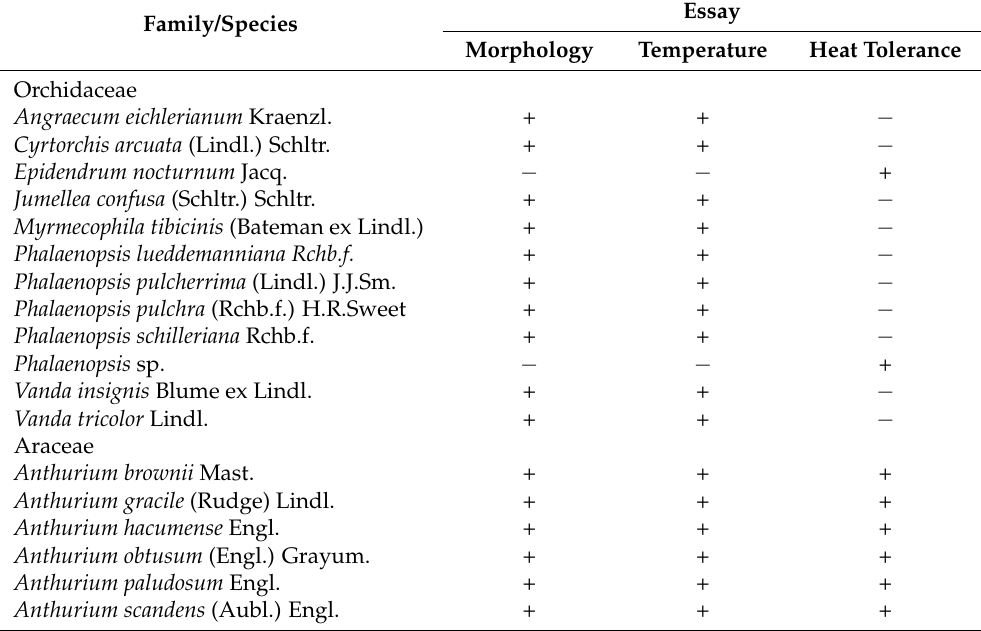
Table A1. Species that were used in the different essays. Species names and the essays in which they were used (+) are given. The minimum sample size per species was three. Species names follow the checklist in